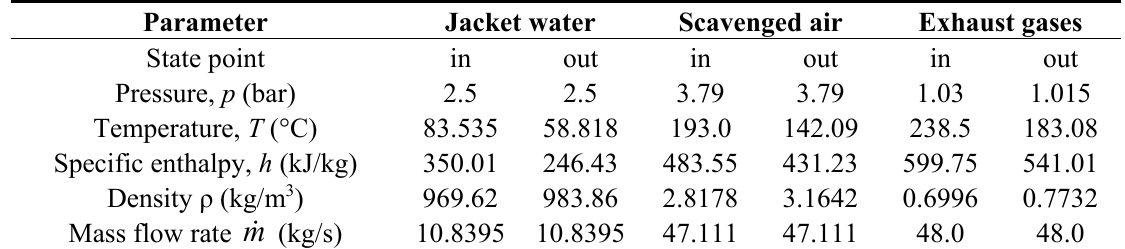
Table 9. Jacket water, scavenged air and exhaust gases state points after